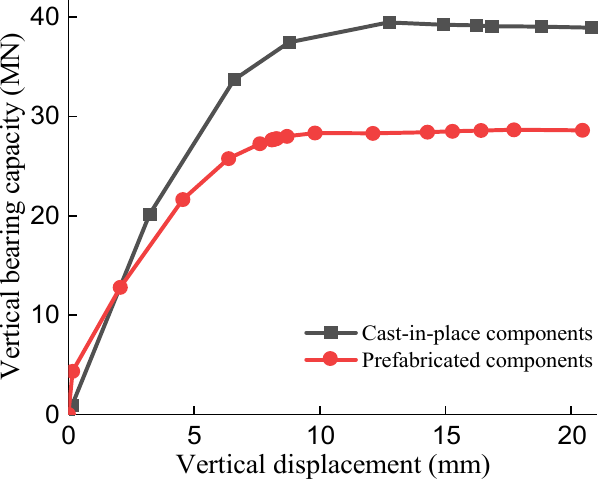
Figure 22. Displacement–load comparison diagram of full-scale socket connection. Table 5. Summary of the vertical bearing capacity